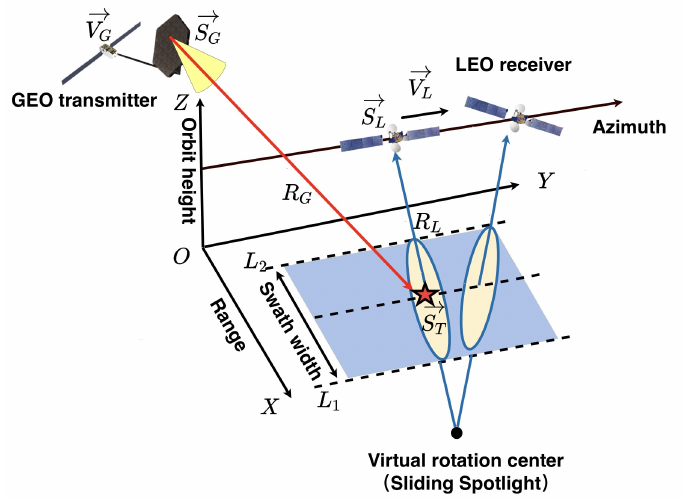
Figure 3. Geometry of GTLR-BiSAR range-Doppler geolocation in the SS mode (not